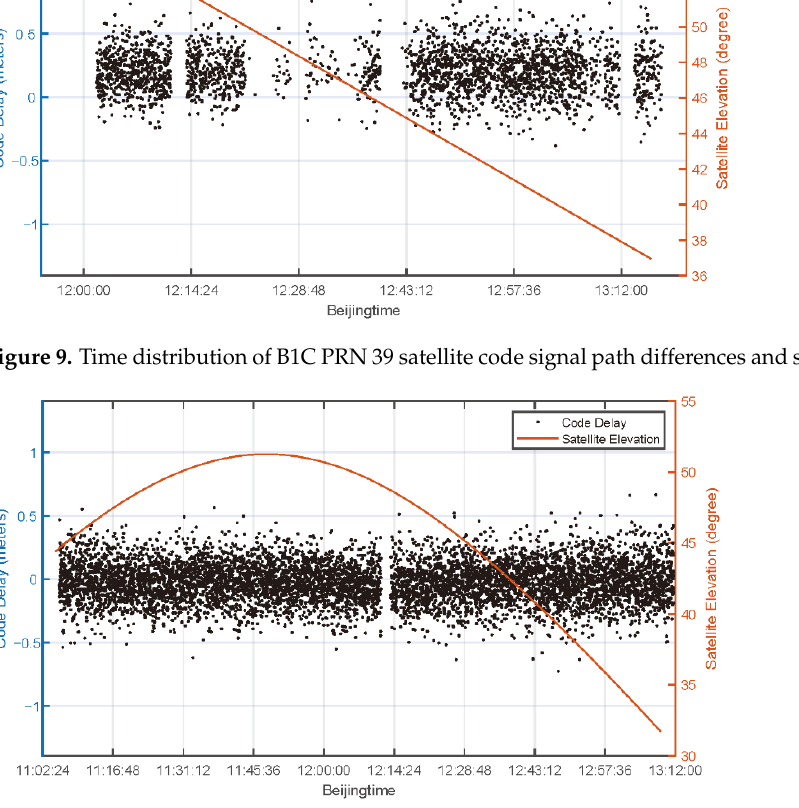
Figure 10. Time distribution of L5C PRN 4 satellite code signal path differences and satellite eleva- tion.